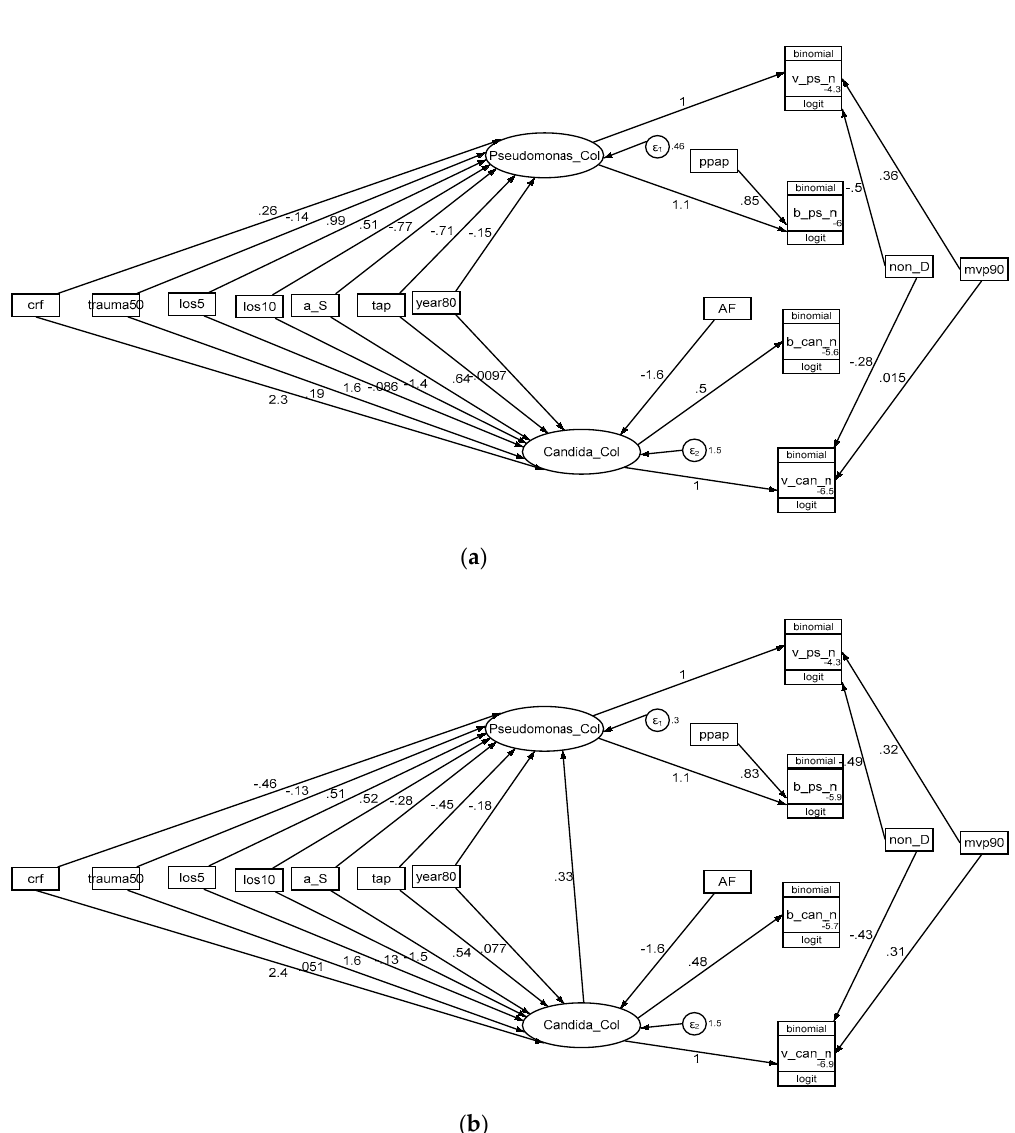
Figure 5. A GSEM founded on CAPI concepts without ( a , model 1) and with ( b , model 2) an interaction term between Pseudomonas colonization and Candida colonization. The model including in interaction term (model 2) is optimal. Candida _col, and Pseudomonas _col (ovals) are latent variables representing Candida , and Pseudomonas colonization, respectively. The variables in rectangles are binary predictor variables representing the group-level exposure to the following; a trauma ICU setting (trauma50), mean or median length of ICU stay < 5 days (los5), mean or median length of ICU stay ≥ 10 days (los10), year of study publication (year80), exposure to a topical anti-septic based prevention method (a_S), exposure to an anti-fungal based prevention method (AF), exposure to a TAP based prevention method (tap), exposure to a non-decontamination based prevention method (non-D), use of mechanical ventilation more for than 90% of the group (mvp90) or exposure to PPAP (ppap). The circles contain error terms ( ε ) associated with the latent variables. The three-part boxes represent the count data for Candida , and Pseudomonas VAP (v_can_n, v_ps_n) and bacteraemia (b_can_n, b_ps_n) which are each logit transformed with the total number of patients in each group as the denominator using the logit link function in the generalized model of the GSEM. Corresponding models (Models 3 to 8) for Acinetobacter colonization and models excluding studies with LOS < 5 days are shown in the ESM (Figures